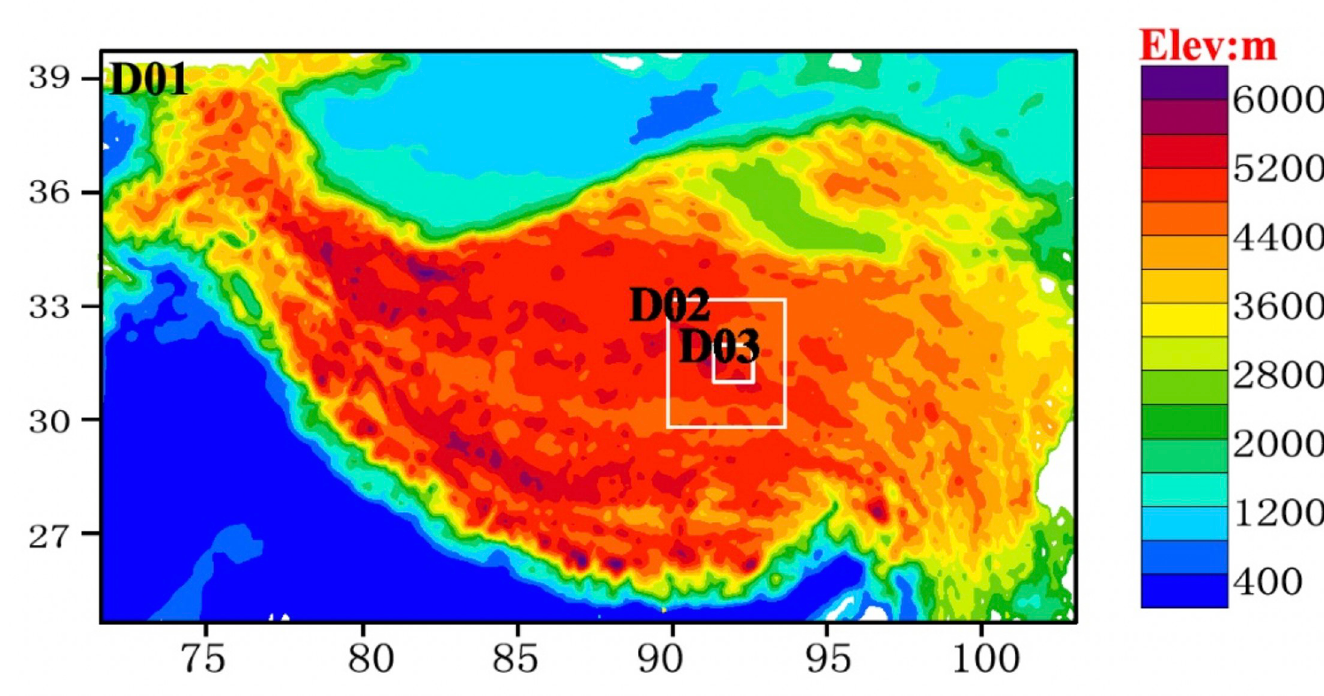
Fig 2. Nested domains used in the WRF model simulations.